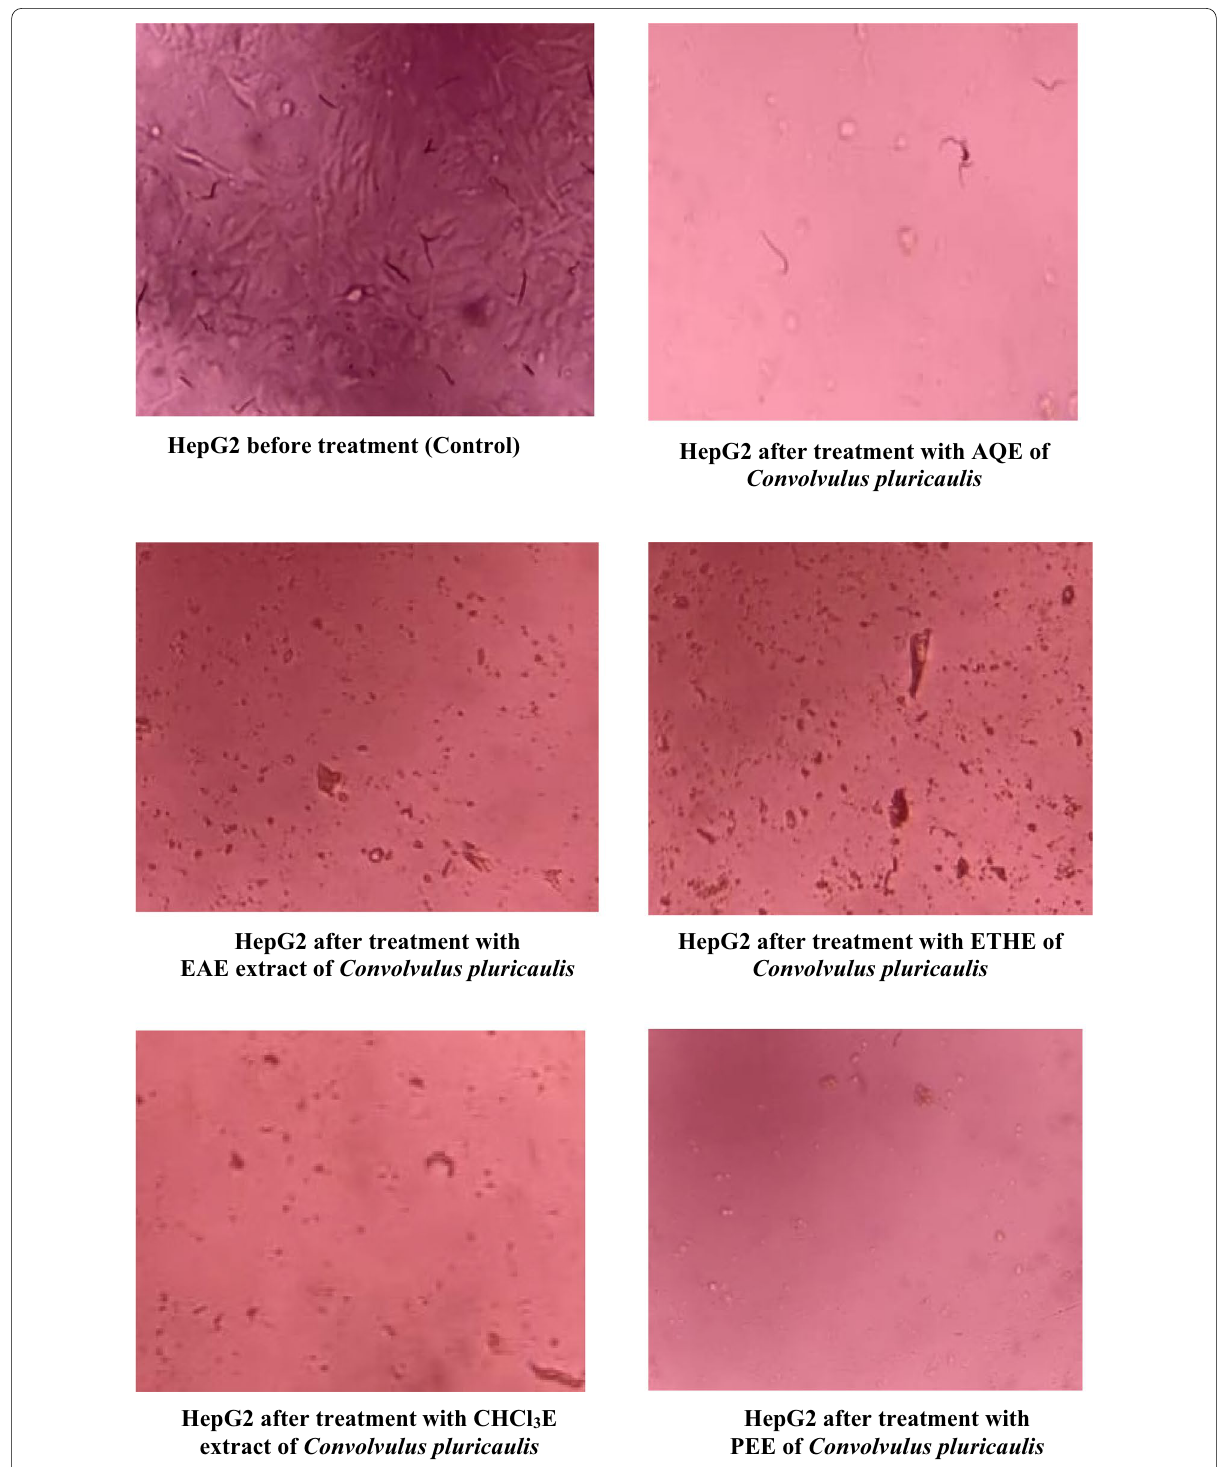
Fig. 3 Images of stained HepG2 cells treated with different extracts from Convolvulus pluricaulis in a time-dependent